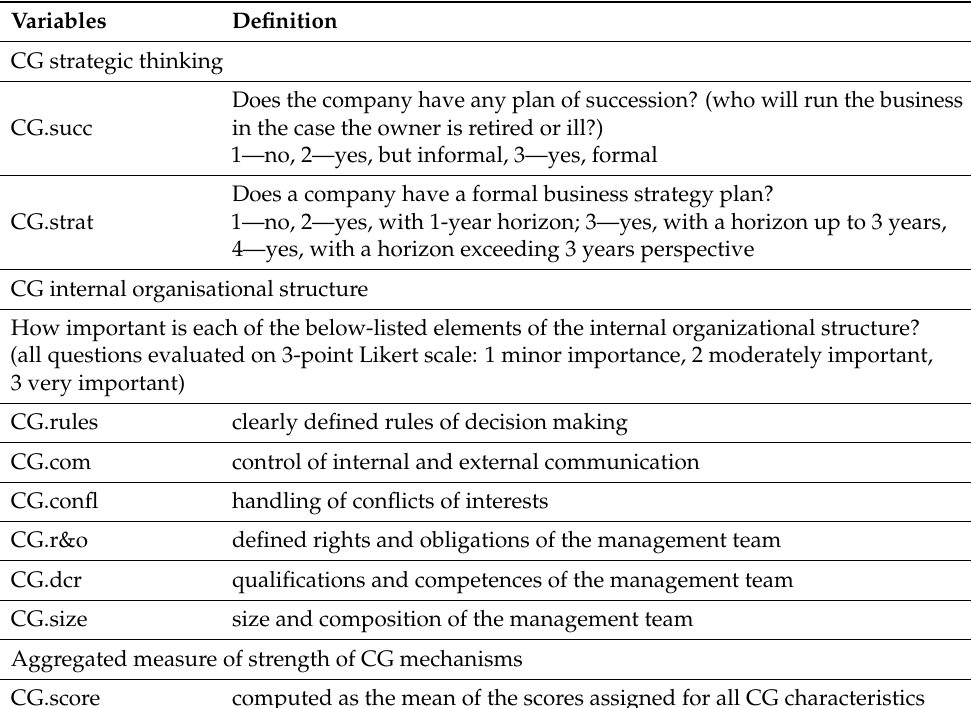
Table 3. The variables and the related survey questions in a corporate governance